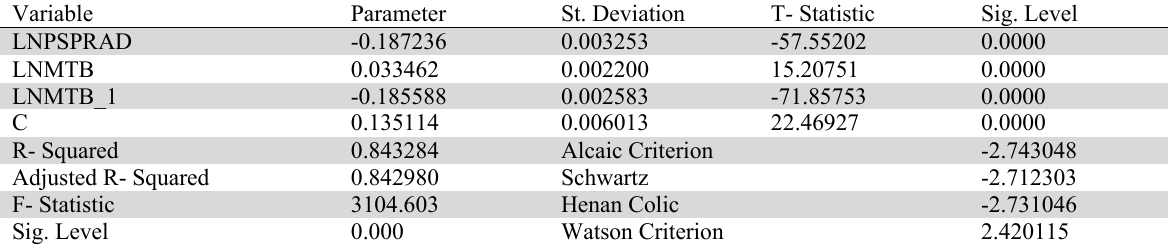
The Relation between Financial Flexibility with ash Opportunity